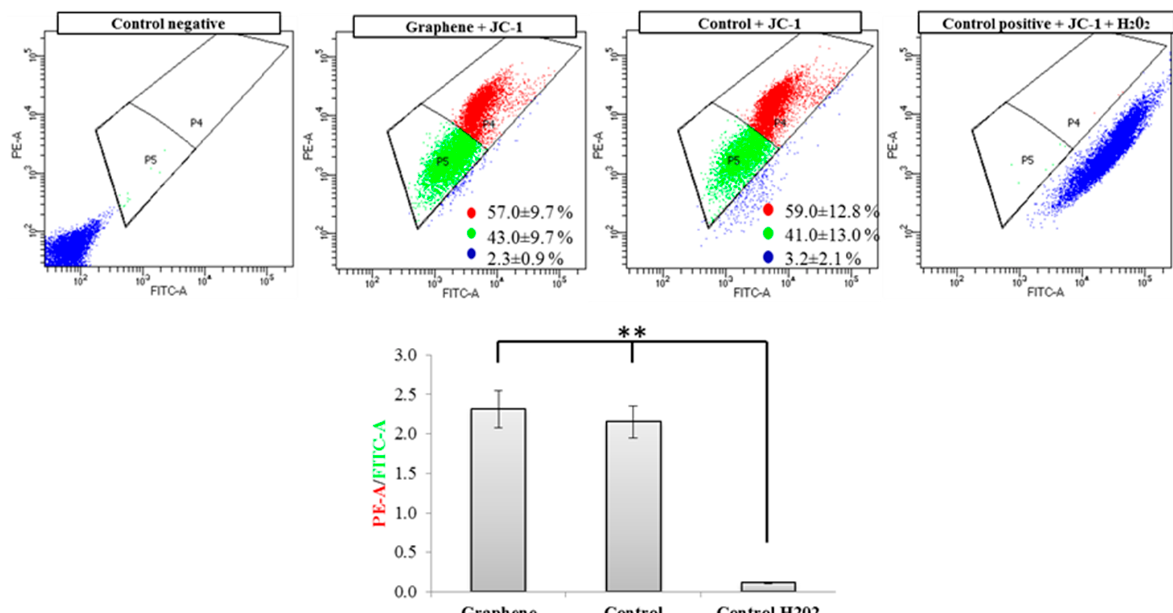
Figure 8. Evaluation of mitochondrial membrane potential using JC-1 dye. Cytograms of JC-1-stained cells; Red populations—cells with high membrane potential. Green populations—cells with low membrane potential. Blue populations—cells with high mitochondrial depolarization. Bar chart of red/green fluorescence intensity ratio of JC-1-stained cells. Data from three independent experiments are presented as mean ± SD (standard deviation) (n = 10,000 cells). ** - statistically significant differences.